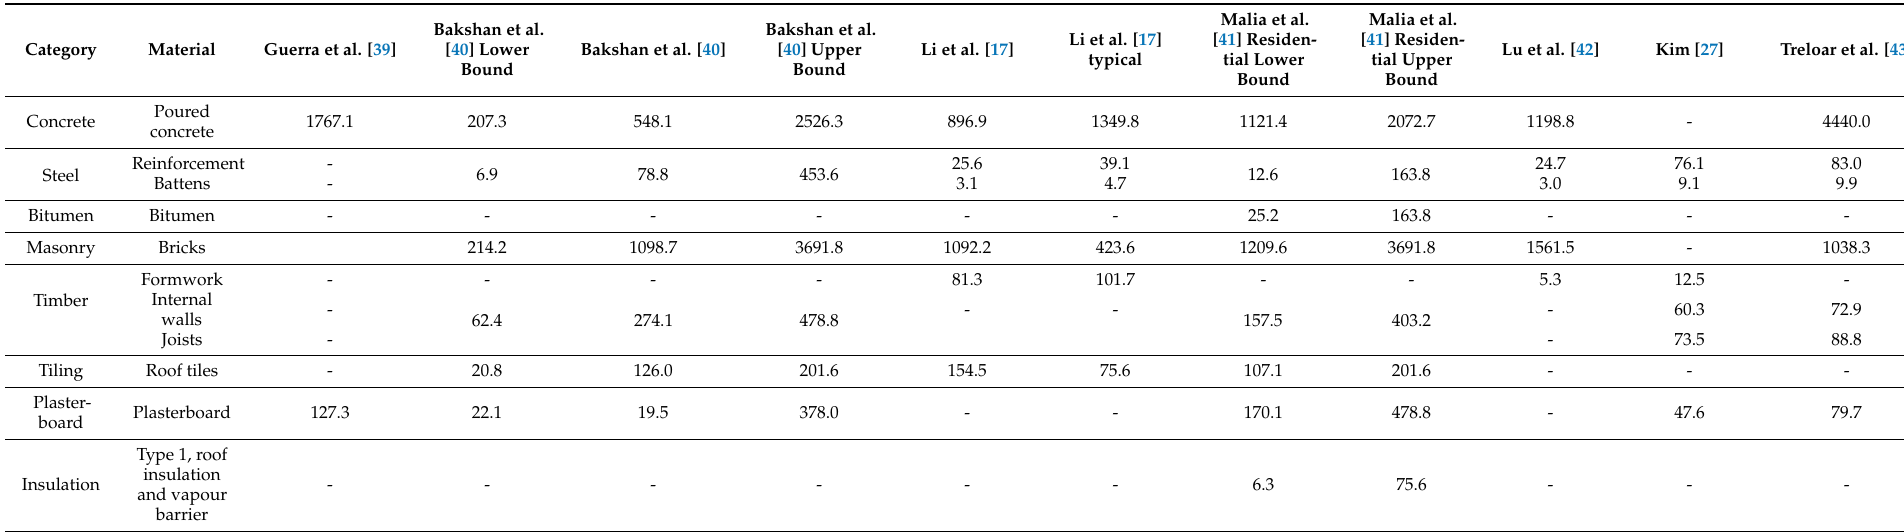
Table A1. Waste generation for Case A conventional construction based on the literature (kg).